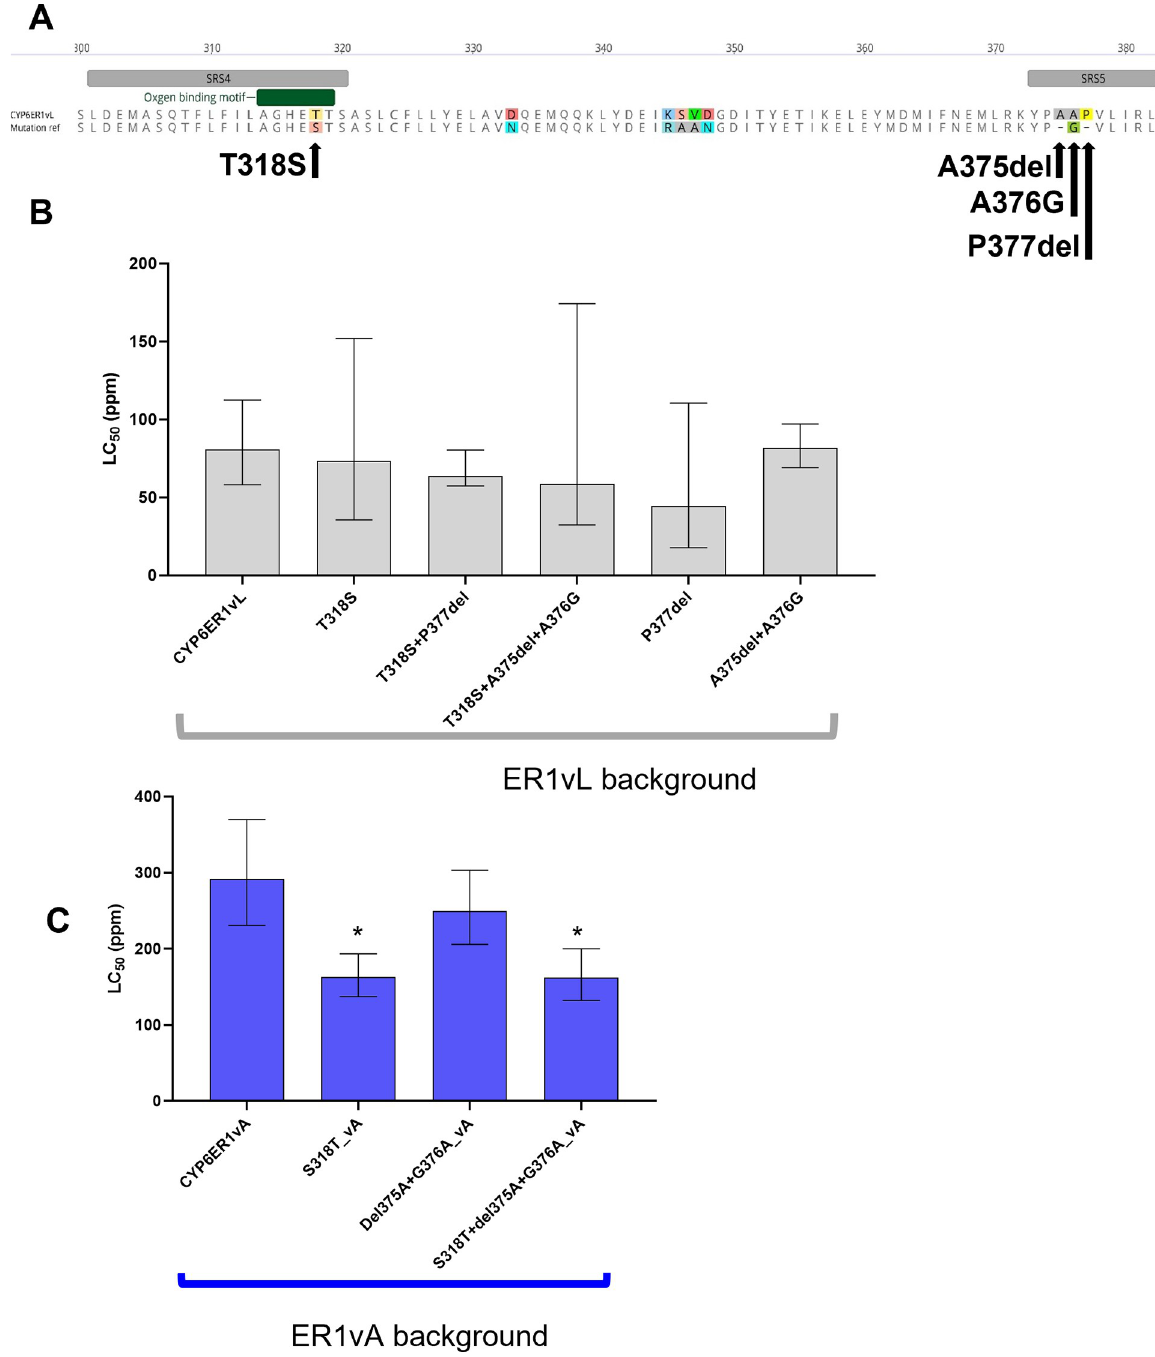
Fig 3. Sensitivity of transgenic strains of Drosophila melanogaster expressing mutated CYP6ER1 variants to ethiprole. A) Amino acid alignment of CYP6ER1vL and a notional CYP6ER1 sequence displaying the nature and position of mutations previously implicated in imidacloprid resistance in the SRS4 and SRS5 of CYP6ER1vA and CYP6ER1vB. B, C) Lethal Concentration 50% (LC 50 ) values derived from full dose-response bioassays are displayed for D . melanogaster strains expressing CYP6ER1vL variants to which mutations previously implicated in imidacloprid resistance in the SRS4 and SRS5 of CYP6ER1vA were added (B), or CYP6ER1vA to which mutations previously implicated in imidacloprid resistance were removed (C). For comparison LC 50 values derived from flies expressing the wildtype versions of CYP6ER1vA and CYP6ER1vL are shown. Error bars show 95% CI (n = 4). Significant differences (p = < 0.05) in LC 50 values of fly lines expressing CYP6ER1 mutated variants and the respective wildtype fly line (CYP6ER1vA or CYP6ER1vL), identified by z- tests using the compParm() function of the ’drc’ package [34], are indicated using an asterisk above relevant bars. See also S4 and S5 Tables.